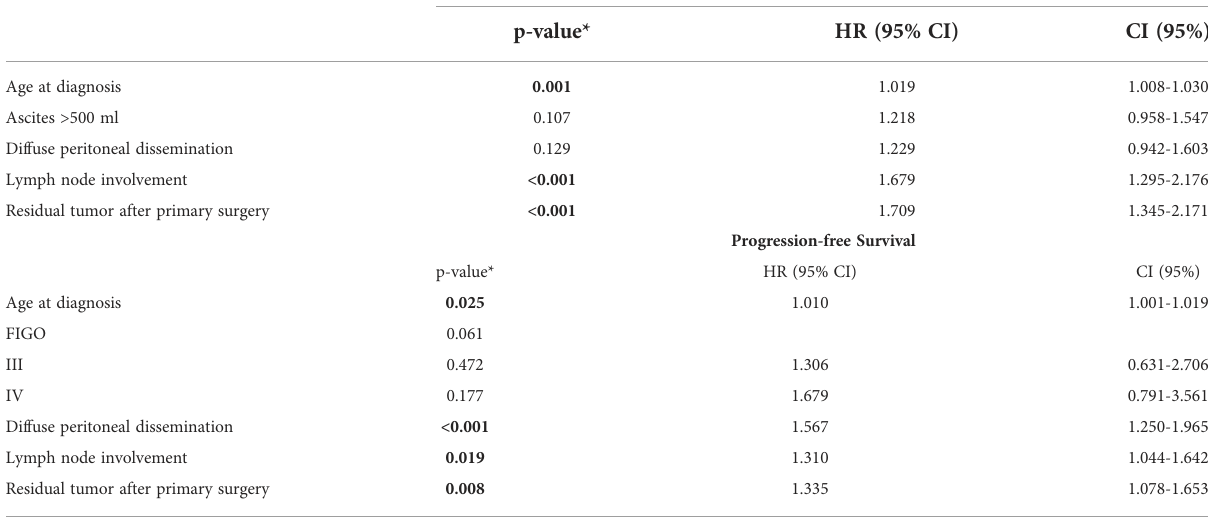
CI, con fi dence interval. FIGO, International Federation of Gynaecology and Obstetrics. HR, hazards ratio. *The bold values indicated statistically signi fi cant